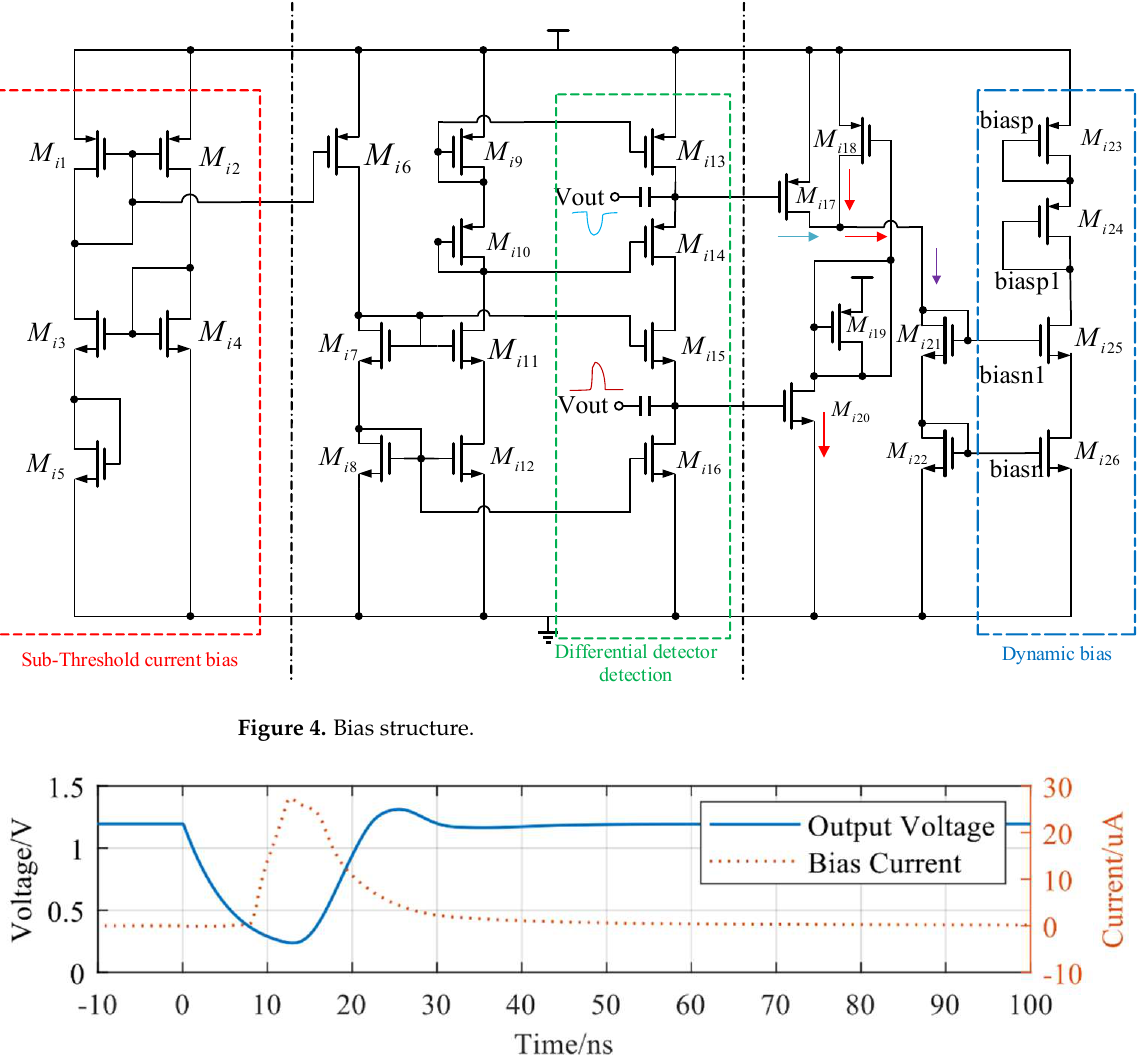
Figure 4. Bias structure.